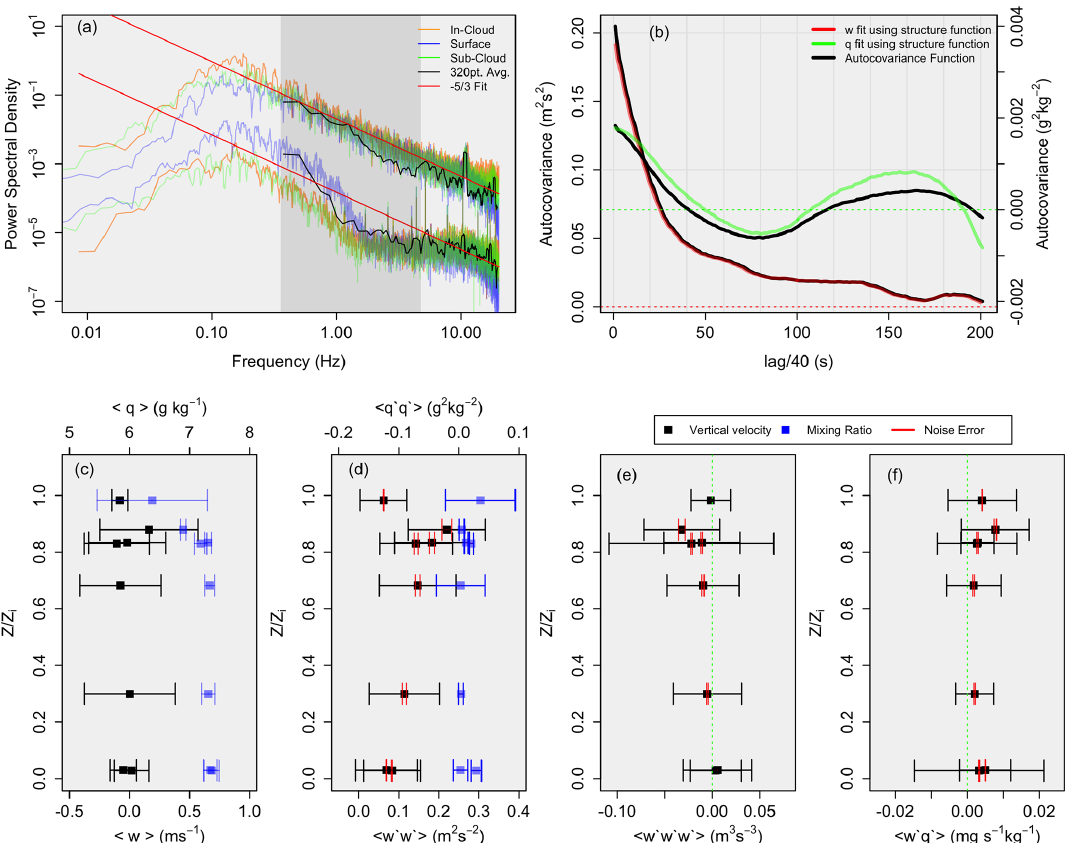
Figure 1. All data presented are from RF3. (a) Power spectral density for three different horizontal flight legs, including in-cloud (orange), sub-cloud (green), and near-surface (blue) fit with a − 5 / 3 power law (red); the upper fit is vertical velocity (m 2 s − 1 ), and the lower fit is q (g 2 kg − 2 ). The overlaid black spectra represent a single spectrum using a 320-point average. The light gray envelope represents the 0.3 to 5Hz range. (b) Autocovariance functions of vertical velocity and q (black) with the fit structure function (green for q and red for vertical velocity). (c) Leg-mean vertical velocity (black) and q (blue), wherein the error bars represent the square root of the total variance. (d) As in (c) , except for the variance. Red error bars represent the noise error, while the remaining error bars represent the sampling error. (e) As in (d) , except for vertical velocity skewness. (f) As in (d) , except for the flux w (cid:48) q (cid:48)